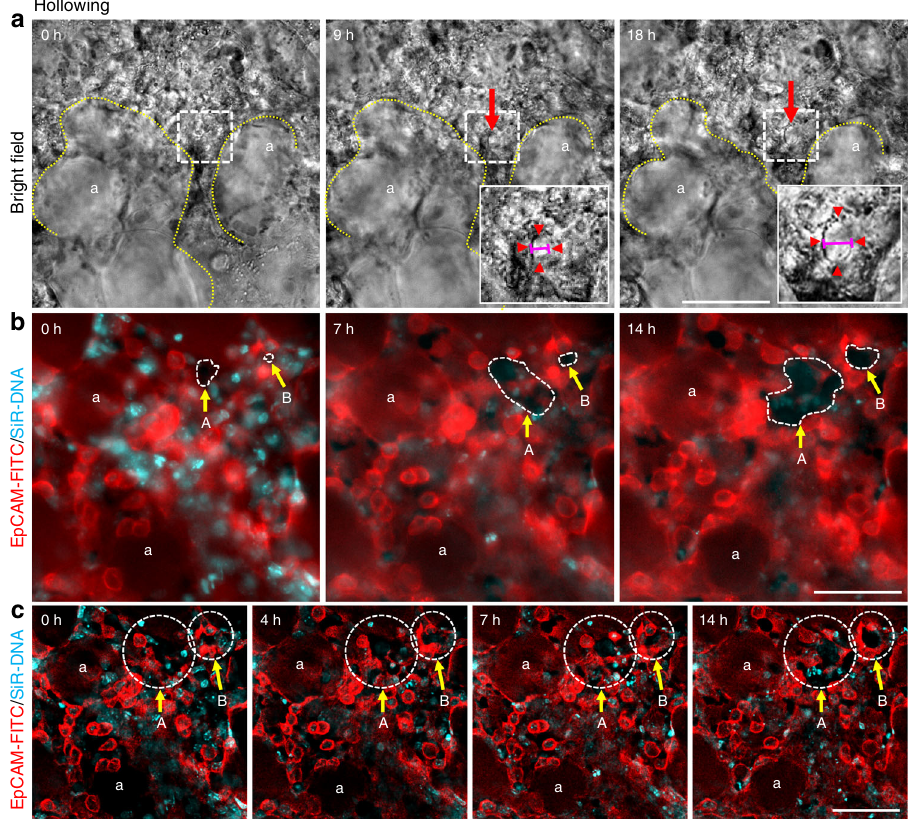
Fig. 4 Cell hollowing in PCLSi. a Bright fi eld images from 18 h time-lapse video of P3 PCLS (Supplementary movie 7) shows ‘ hollowing ’ within the parenchyma at 0, 9 and 18 h (red arrow, and red arrowheads in white boxed area, dotted yellow lines outline surrounding airspaces). Inserts in a enlarged views of the white boxed area. Pink horizontal lines in insert depict width of ‘ hole ’ expanding (compare a , middle panel to a , right panel). Scale bar = 50 µ m. b EpCAM-FITC (red)/SiR-DNA (cyan) labelled raw images of P3 PCLS from 14 h time-lapse video (Supplementary movie 8) show ‘ hollowing ’ at 0, 7 and 14 h (white dashed areas, A and B, yellow arrows). Scale bar = 50 µ m. c Deconvolved still images from 14 h time-lapse video (Supplementary movie 9) show EpCAM + ve epithelial cell migration and rearrangement around the newly formed hollows/airspaces (white circles, A and B yellow arrows,). White ‘ a ’ indicates alveolar airspaces, n = 3 independent experiments using 3 separate mice, with duplicate slices from each mouse per experiment. Scale bar = 50 µ